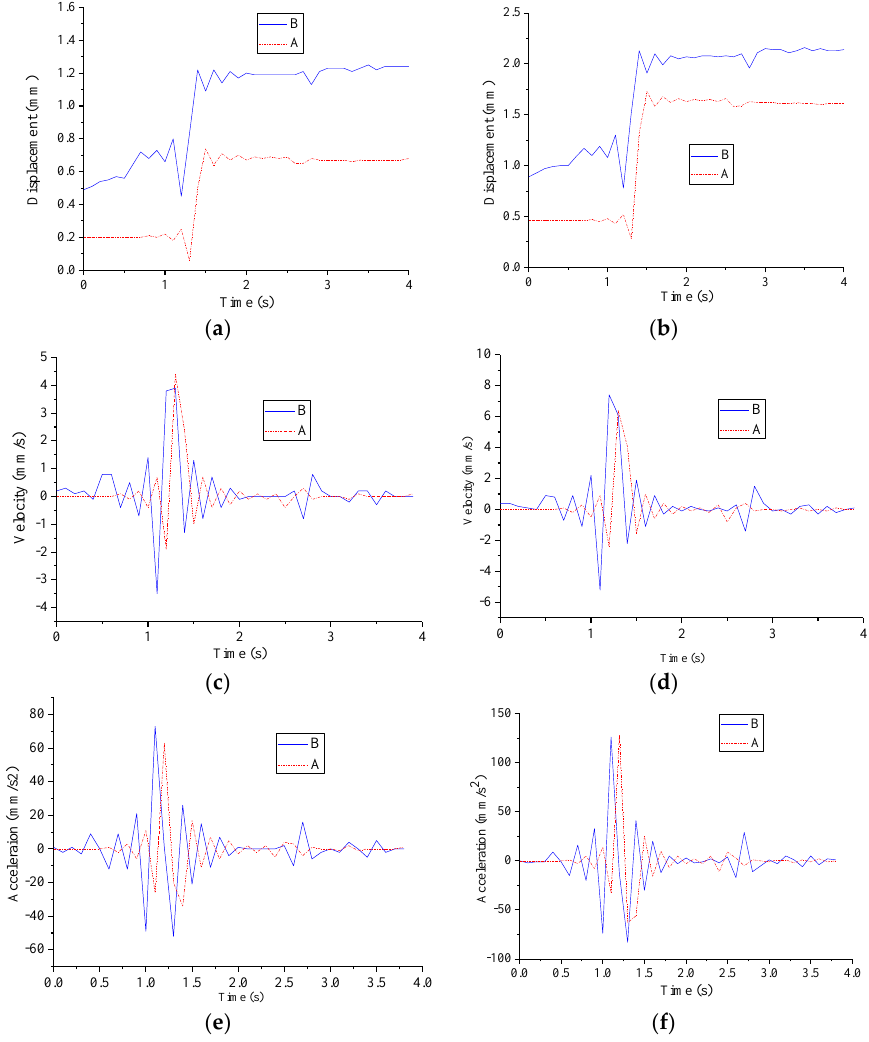
Figure 14. Response of the A/3 column in case G2: ( a ) displacement time-history at the top of the first floor; ( b ) displacement time-history at the top of the second floor; ( c ) velocity time-history at the top of the first floor; ( d ) velocity time-history at the top of the second floor; ( e ) acceleration time-history at the top of first floor; and ( f ) acceleration time-history at the top of the second floor.